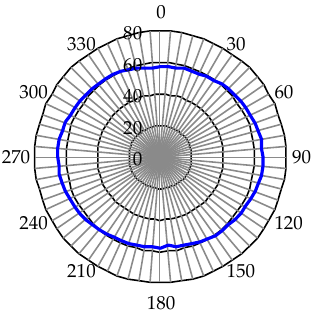
Figure 5. Variations of the incident polarization on the focusing intensities of the BPLC microlens array under the applied voltage of 70 V.